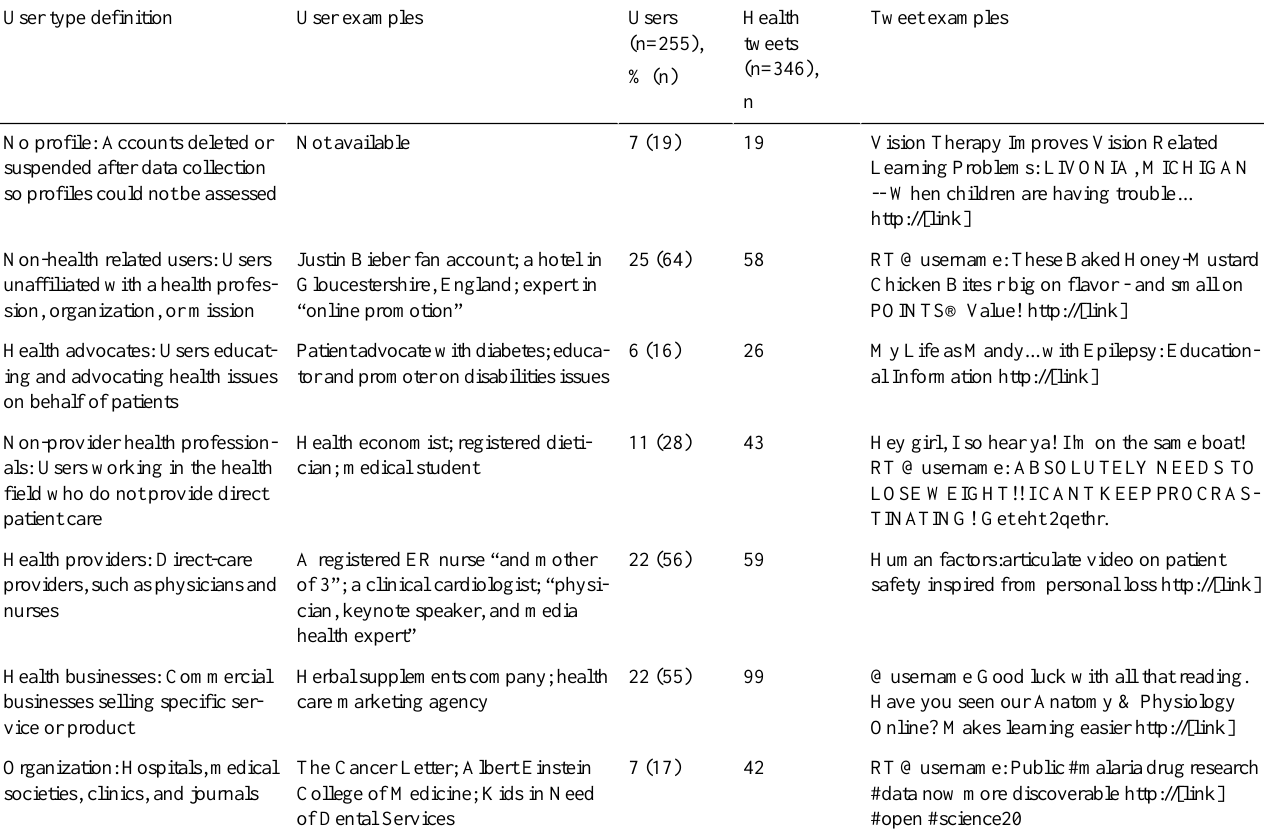
Table 2. Types of